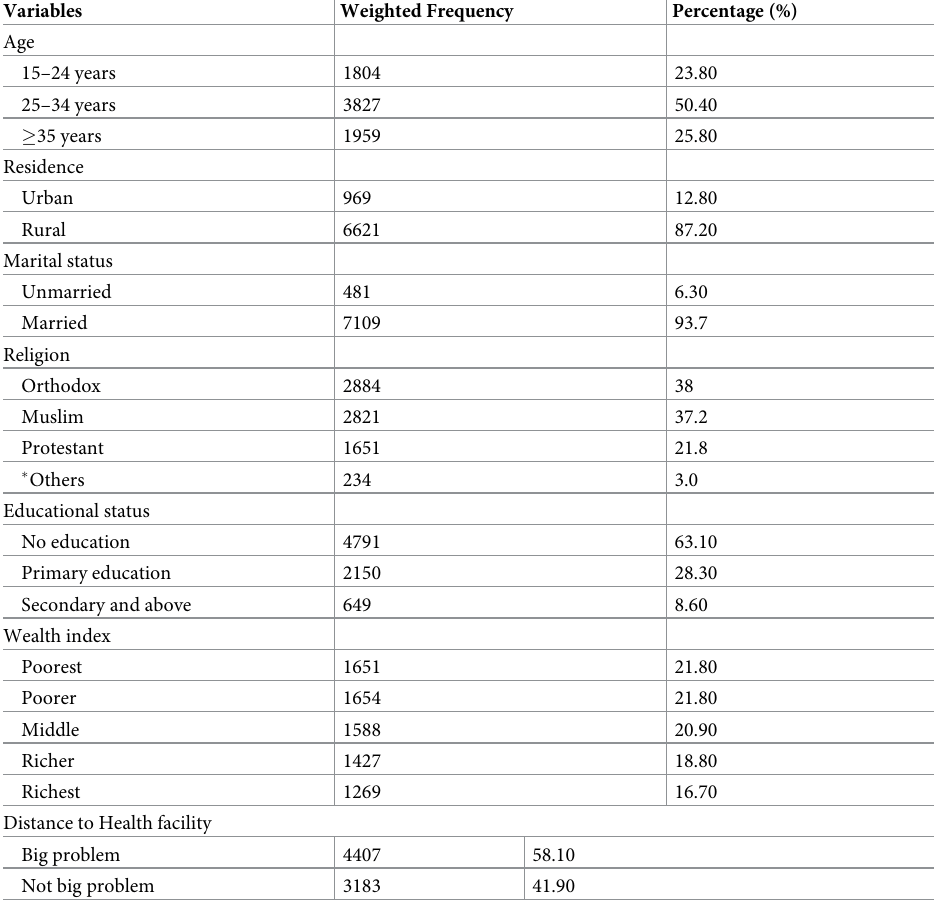
Table 2. Socio-demographic and economic characteristics of postpartum women in